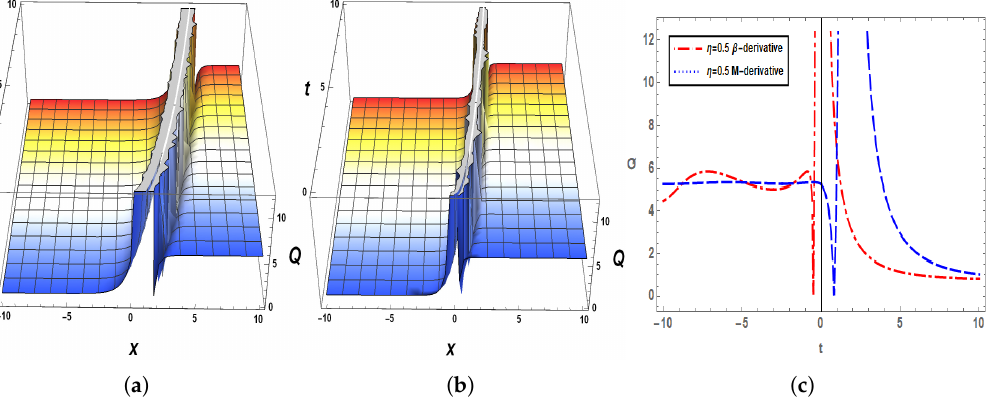
Figure 7. For Q 8,2 ( x , t ) , we consider µ = 0.5, γ = − 0.8, σ = 0, θ = 1, ϑ = 1, (cid:101) = 0.5, λ = 1, and C = − 1. ( a – c ) show 3 D , as well as the 2 D plots with Beta and M-truncated derivatives for η = 0.5.